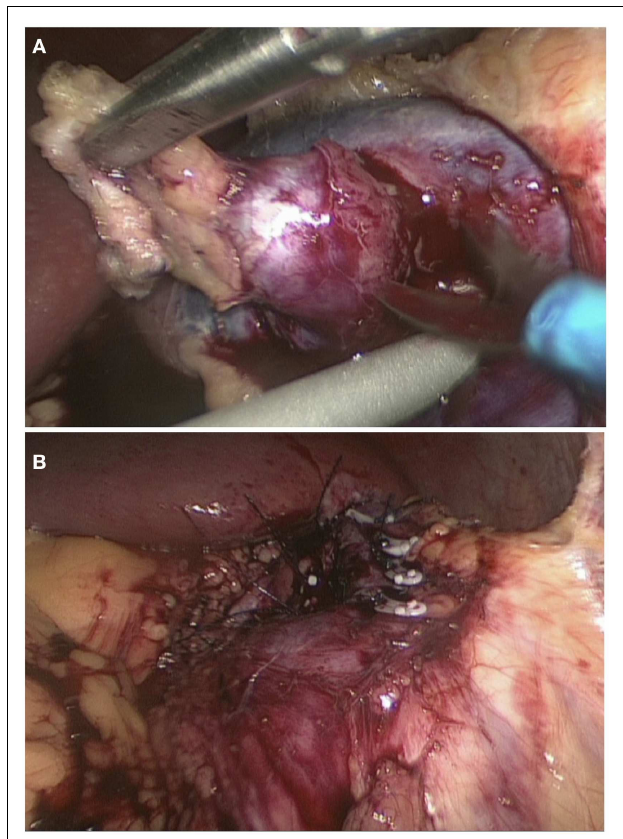
FIGURE 3 | Laparoscopic wedge resection of reninoma . Dissection of the tumor with scissors (A) and the closure of the defect with interrupted mattress suture (B)